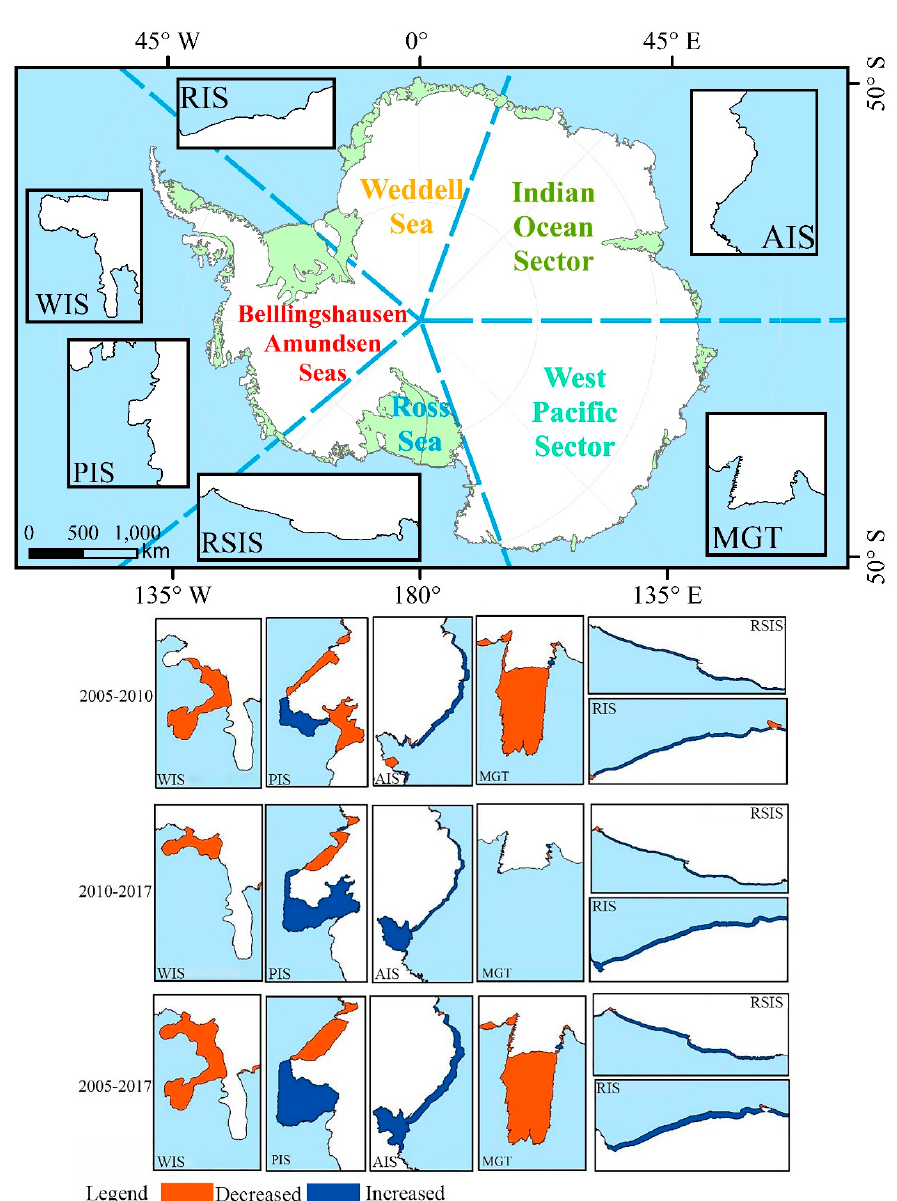
Figure 6. Locations of six ice shelves along the Antarctic coast, which have undergone significant changes from 2005 to 2017. The green color indicates the geolocations of ice shelves around the Antarctica. The area changes of six ice shelves from 2005 to 2017 are shown below. The red shading indicates the area decreased and the blue shading indicates the area increased over this period. The contours are of the 2005 coastline from the present calculations. Data of 2005–2010 for MGT are up to end of March 2010 (i.e., after the calving of the giant iceberg C28). WIS, Wilkins Ice Shelf; PIS, Pine Island Shelf; AIS, Amery Ice Shelf; MGT, Mertz Glacier Tongue; RSIS, Ross Ice Shelf; and RIS, Ronne Ice Shelf.